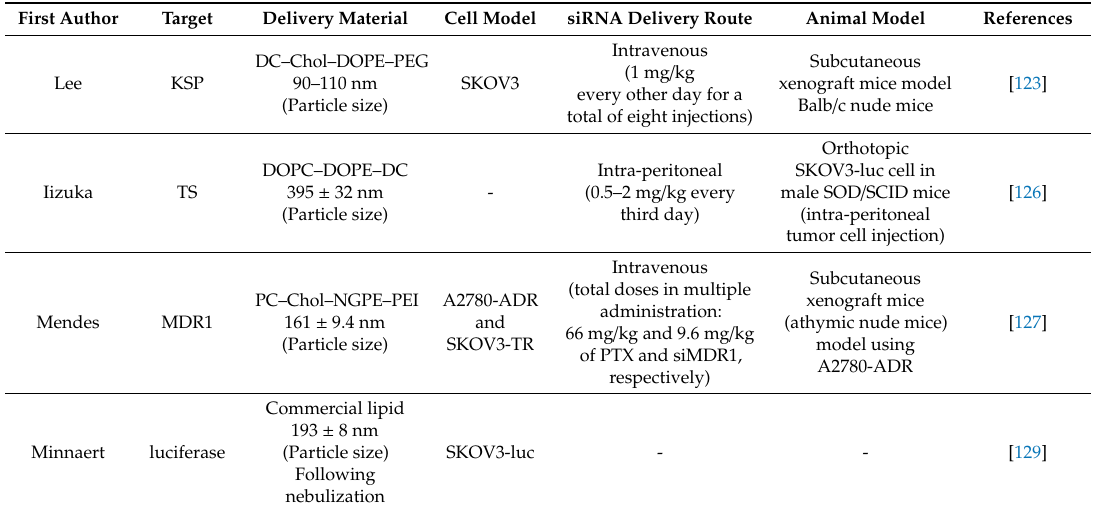
Table 7. Lipid-based delivery